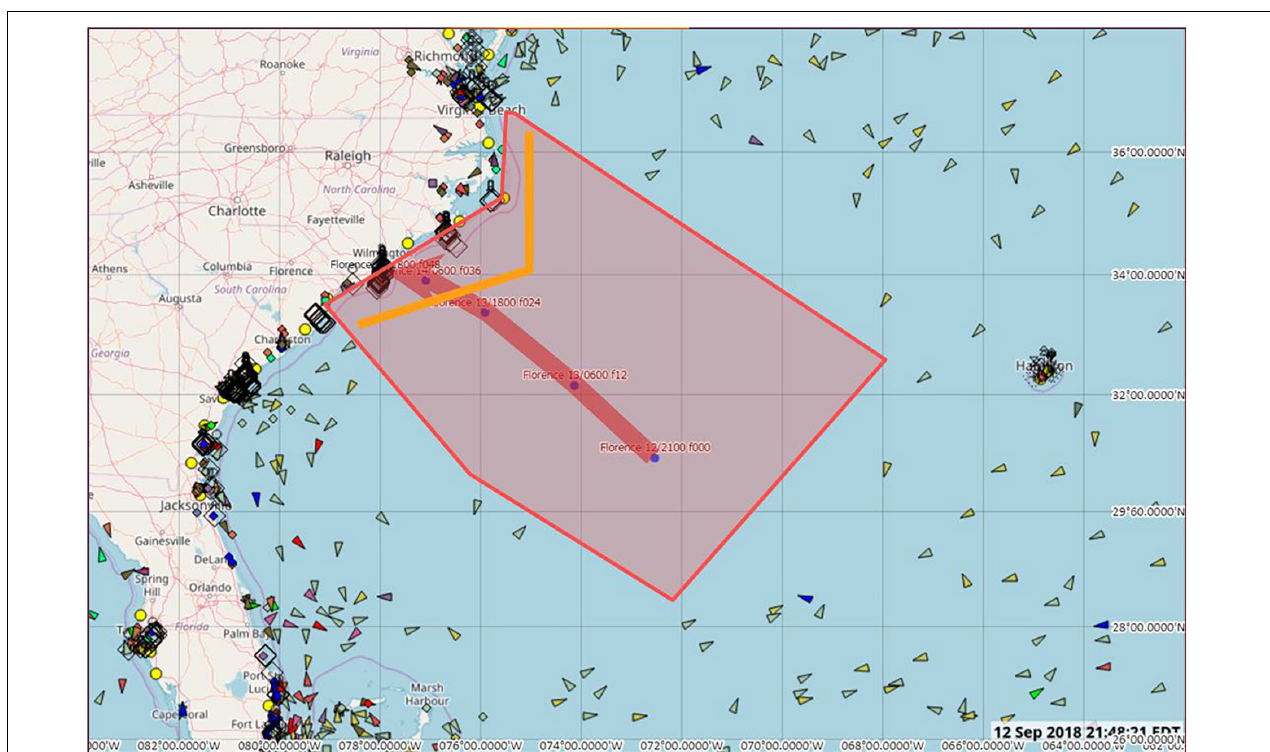
FIGURE 3 | AIS data plot shows ships (small triangles) avoiding Hurricane Florence, 2018. The NWS plans to use this tool to help ensure vessels are receiving the proper warnings and are avoiding hazardous seas, part of a decision support framework in support of a Weather Ready